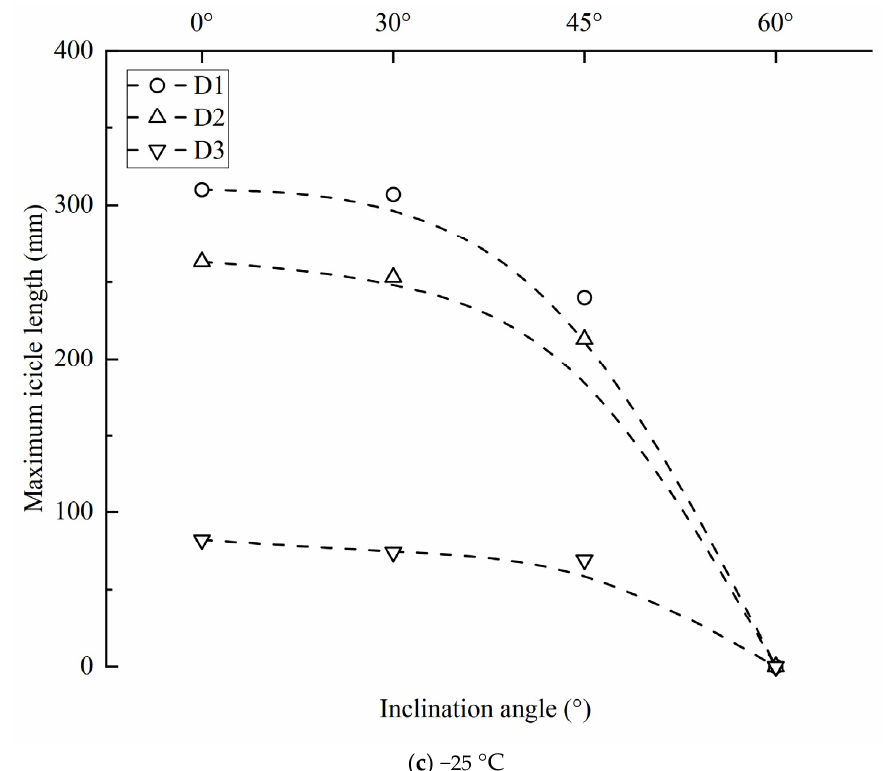
Figure 10. ( a – c ) In fl uence of cable inclination angle on maximal length of icicles.